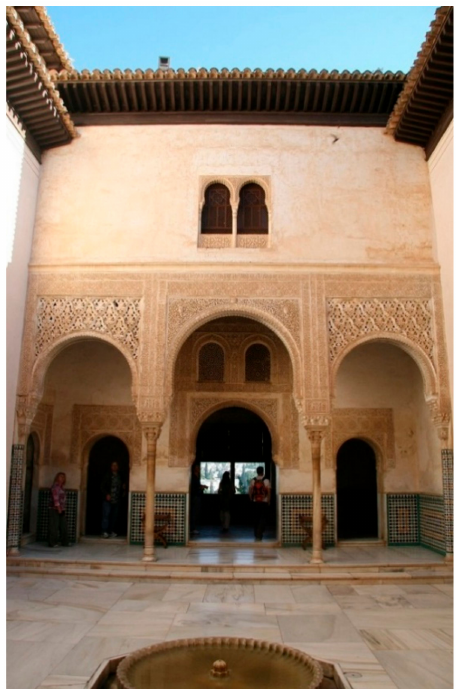
Figure 13. Patio of the Cuarto Dorado precinct with the portico on the north side, Alhambra. © Mar í a Elena D í ez Jorge,